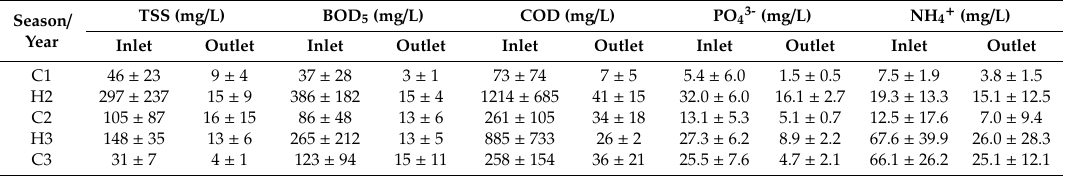
Table 1. Mean ± SD inlet and outlet composition of the wastewater in the CW system during the cold (C) and hot (H) seasons across three consecutive years (1, 2, and 3). (n = 4 for each season). Season / Year